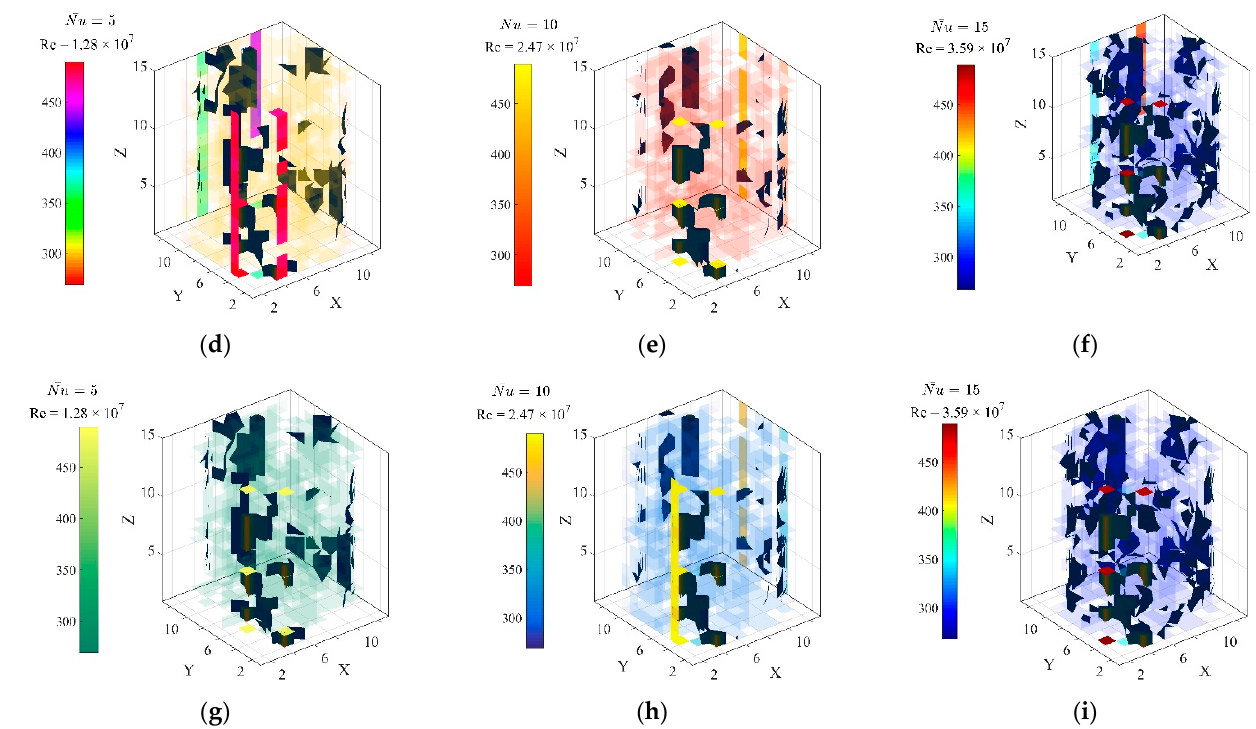
Figure 5. The effect of thermo-fluid properties of inert gas on the temperature distribution (Iso surfaces) of biofuel pellets for the quasi-static torrefaction at 523 K ( a – c ): 5 min, ( d – f ): 10 min, ( g – i ): 15 min (g = 0, q = 1.430 W·m − 2 ·K − 1 , k = 3.056 W·m − 1 ·K − 1 , Pr = 0.0001988).